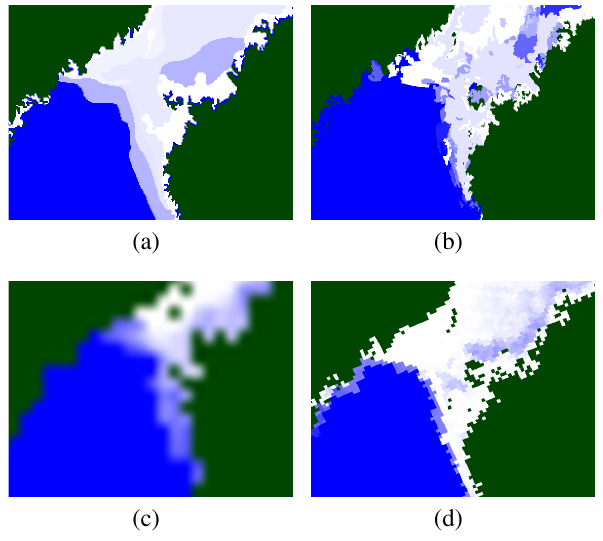
Figure 5. A detail of the 2 February 2014 concentration estimates Fig. 5. A detail of the Feb. 2, 2014 concentration estimates near the ice edge. FMI ice chart concentration near the ice edge. FMI ice chart concentration (a) ; our algorithm (a), our algorithm result (b), bootstrap ice concentration (c), and ASI ice concentration (d). In the image result (b) ; bootstrap ice concentration (c) ; and ASI ice concentra- scales the interval is one degree in both latitude and longitude, the upper left corner is (66 o N,16 o E) and tion (d) . In the image scales the interval is 1 ◦ in both latitude and lower right corner (56 o N,31 o E). longitude; the upper left corner is located at 66 ◦ N, 16 ◦ E, and the lower right corner is located at 56 ◦ N, 31 ◦ Figure 4. FMI ice chart concentration grid for 11 February 2014 (a) ; Fig. 4. FMI ice chart concentration grid for Feb. 11, 2014 (a), ice concentration estimate using our ice concentration estimate using our algorithm (b) ; AMSR-2 boot- algorithm (b), AMSR-2 bootstrap algorithm ice concentration (c), and ASI ice concentration (d). In the strap algorithm ice concentration (c) ; and ASI ice concentration (d) . image scales the interval is one degree in both latitude and longitude, the upper left corner is (66 o N,16 o E) In the image scales the interval is 1 ◦ in both latitude and longitude; and lower right corner (56 o N,31 o E). the upper left corner is located at 66 ◦ N, 16 ◦ E, and the lower right corner is located at 56 ◦ N, 31 ◦ E. 30